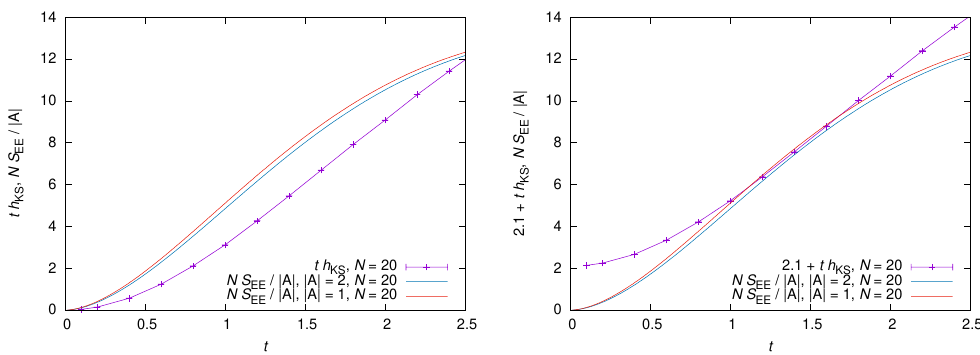
Figure 11 . [Left] SYK model, comparison of th KS and NS EE = j A j . As an initial state, the Fock vacuum annihilated by ^ c j = the same plot, but S EE is shifted by a